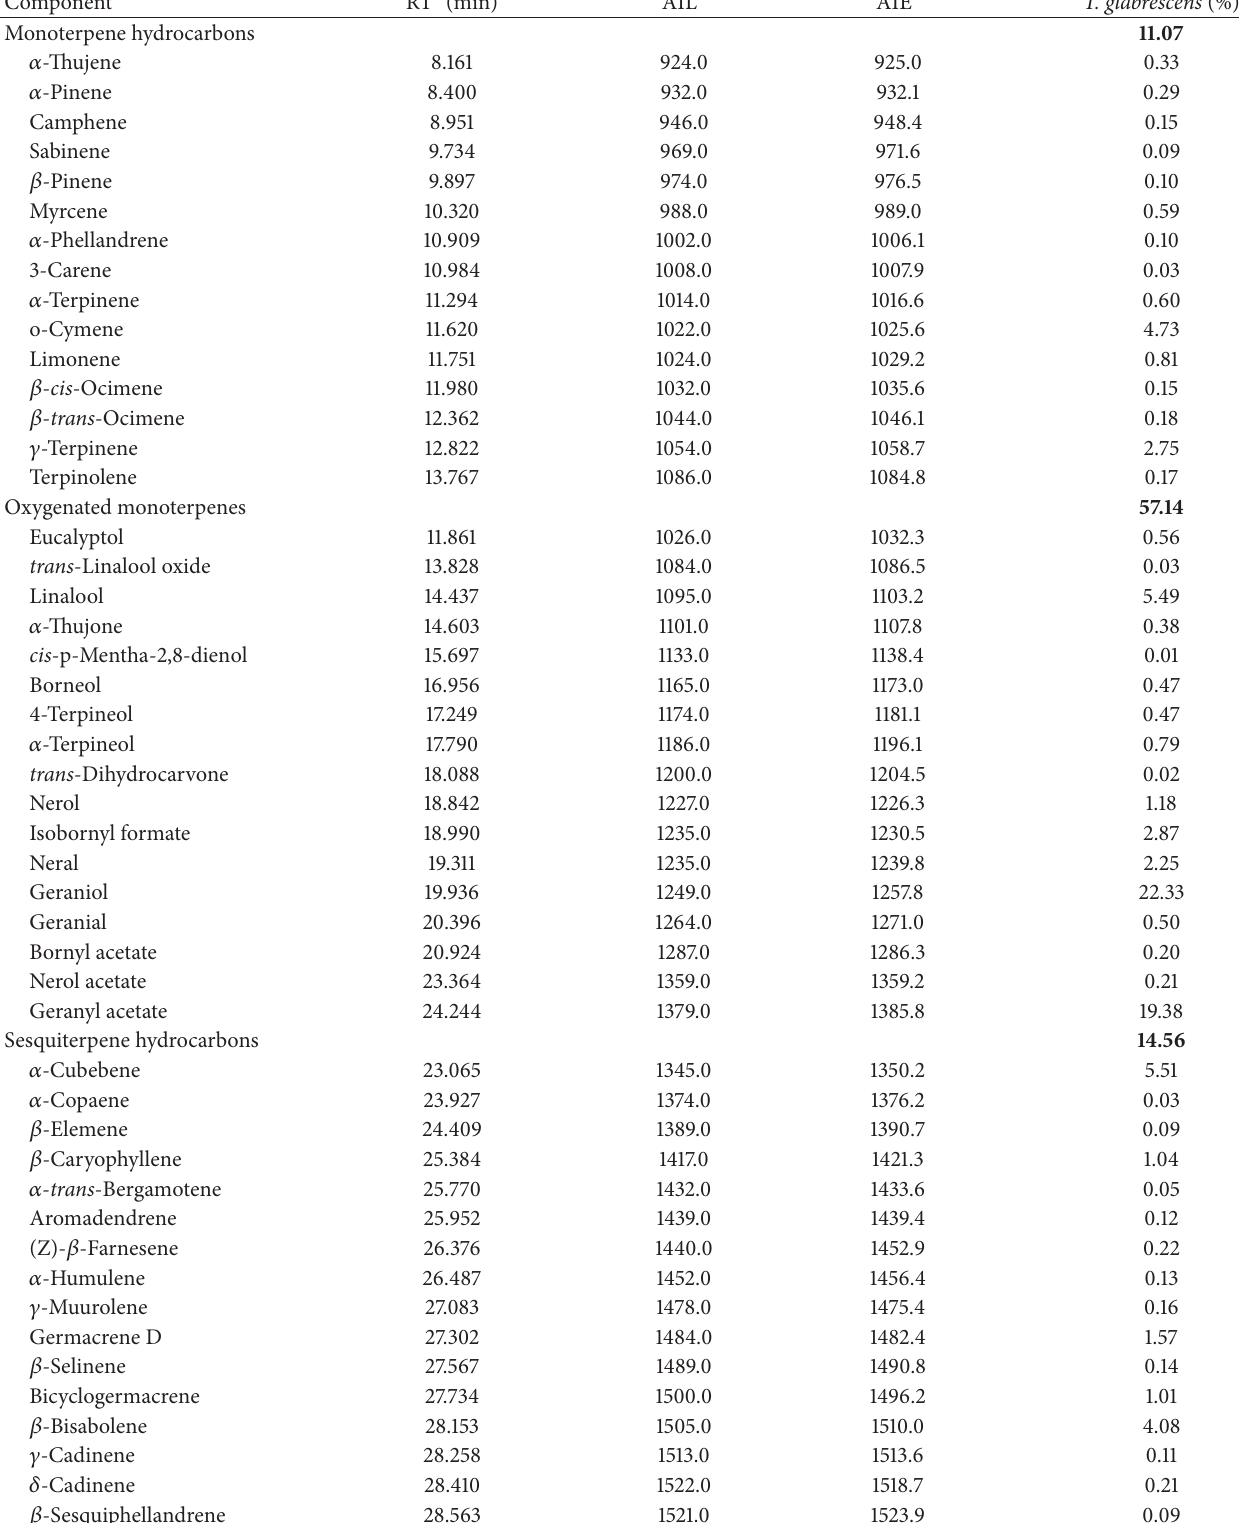
Table 1: Composition of the essential oil of T. glabrescens